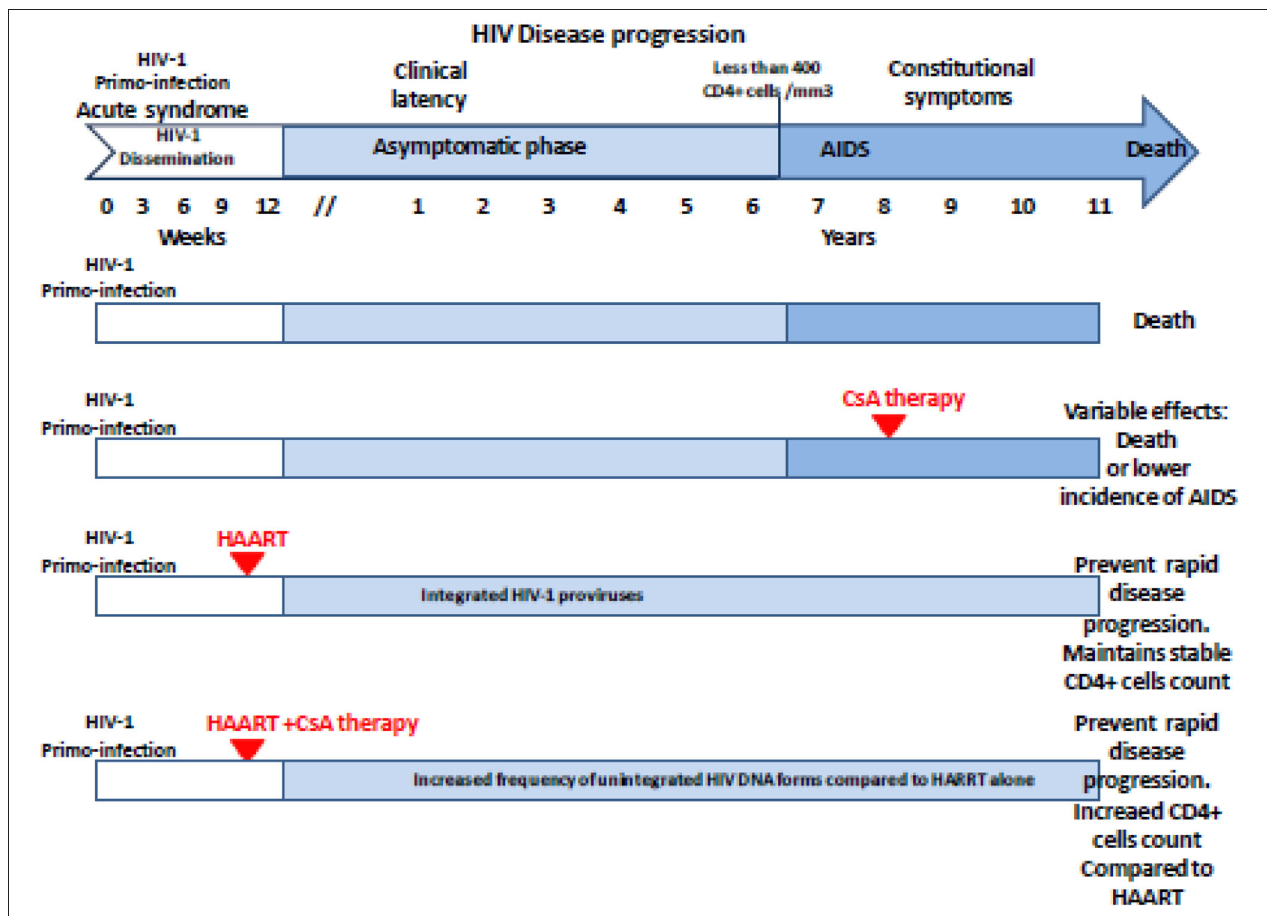
FIGURE 2 | Schematic representation of the antiviral effect of CsA treatment on the HIV-1 disease progression regarding the clinical trials reported in the literature. The effectiveness and beneficial effects of CsA depend on the stage of the disease at which the treatment is given. Unintegrated DNA forms of viral genome increased in the CsA-treated group compared with controls when CsA is given post-primo-infection in association with HAART. AIDS, acquired immunodeficiency syndrome; HAART, highly active antiretroviral therapy; CsA, cyclosporine